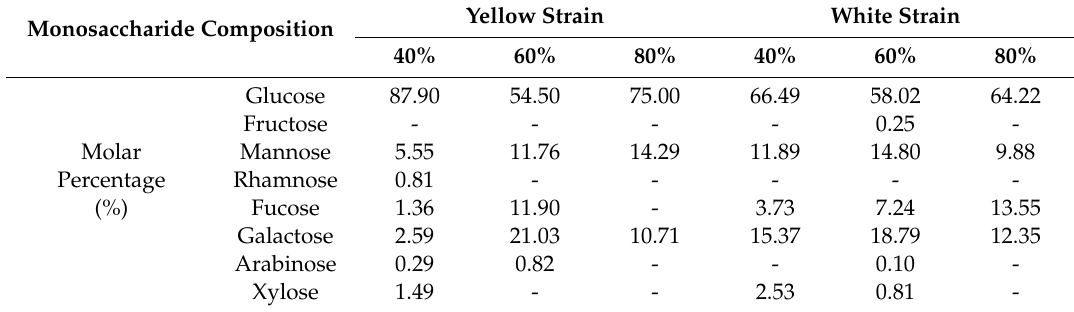
Table 3. Monosaccharide composition of yellow strain and white strain polysaccharides.